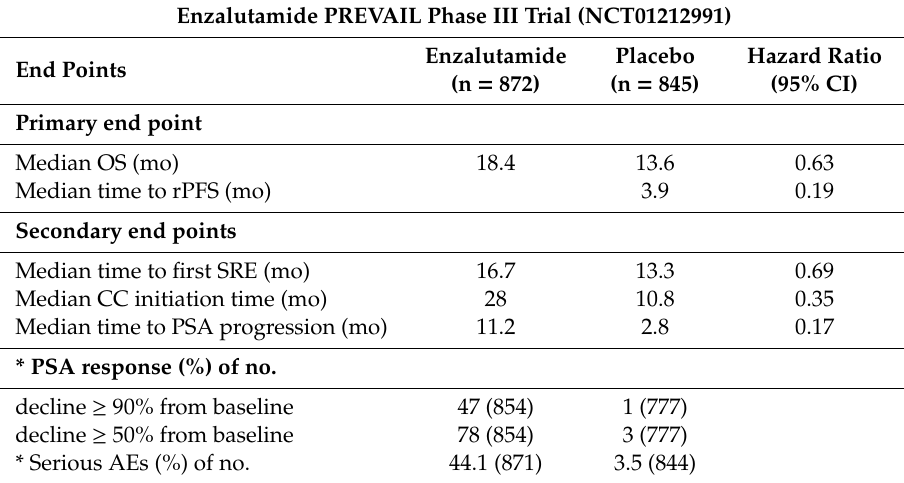
Table 4. Major therapeutic benefits brought by enzalutamide based on